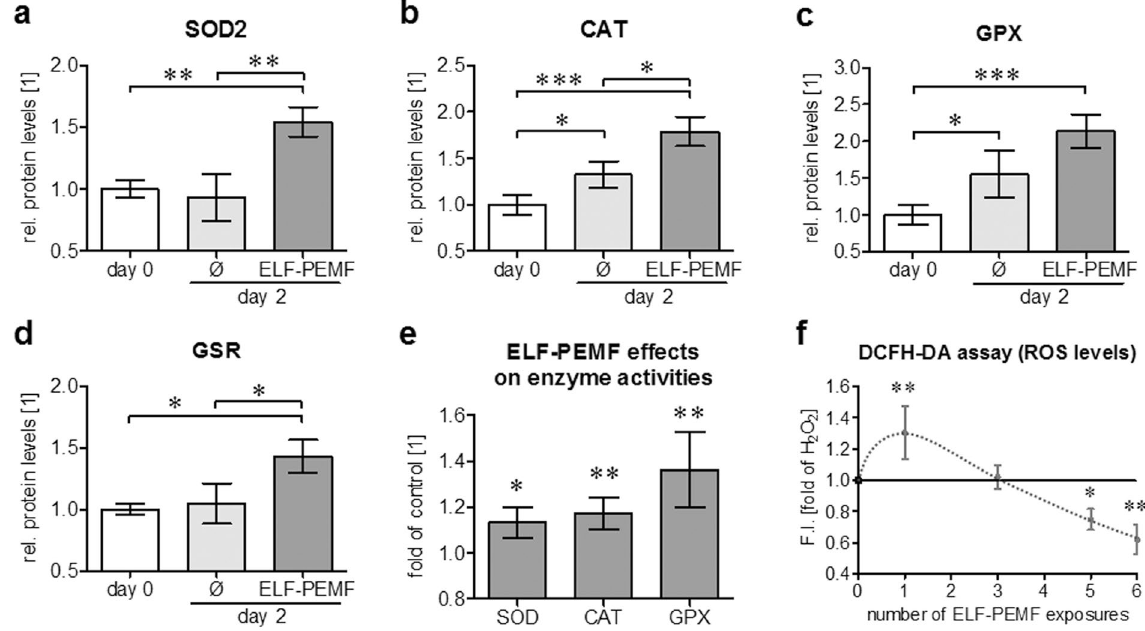
Figure 4. ELF-PEMF exposure increases protein levels and function of antioxidative enzymes in hOBs. hOBs were osteogenically differentiated with or without daily exposure to ELF-PEMF. After 2 days protein levels of SOD2, CAT, GPXs and GSR were determined by Western blot. ( a – d ) Signal intensities were quantified by densitometric analysis using the ImageJ software. Individual samples (N = 9) were analyzed twice (n = 2) to reduce small loading differences. The mean signal intensity of cells on day 0 was set as reference. * p < 0.05, ** p < 0.01 and *** p < 0.001 as indicated (Kruskal-Wallis test followed by Dunn’s multiple comparison test, α = 0.05). ( e ) Changes in enzyme activities (N = 10; n ≥ 2) were determined using test kits. ( f ) ROS levels in hOBs (N = 12, n = 4) after single and repetitive exposures to ELF-PEMF (7 min per day) and additional H 2 O 2 (0.01%) stimulation. ROS levels were determined using the DCFH-DA assay. Results are given as fold of H 2 O 2 treated hOBs. * p < 0.05 and ** p < 0.01 as compared to unexposed cells on day 2 (two-tailed Mann-Whitney test, α =